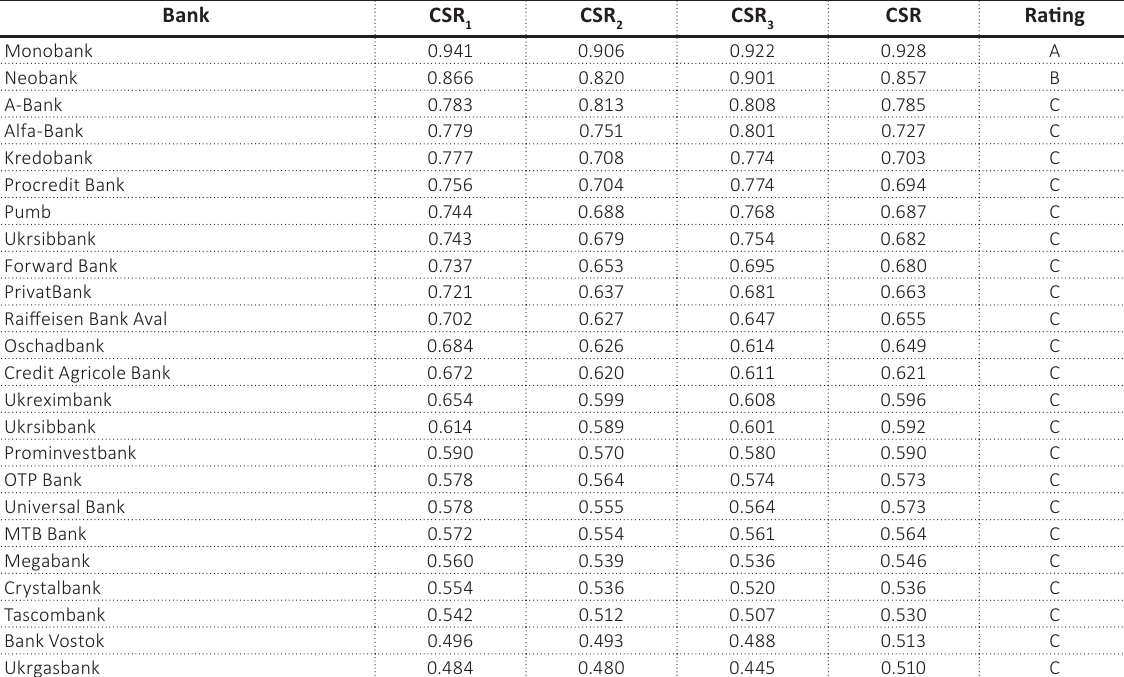
Table B1. Calculation data for digitalization components of corporate social